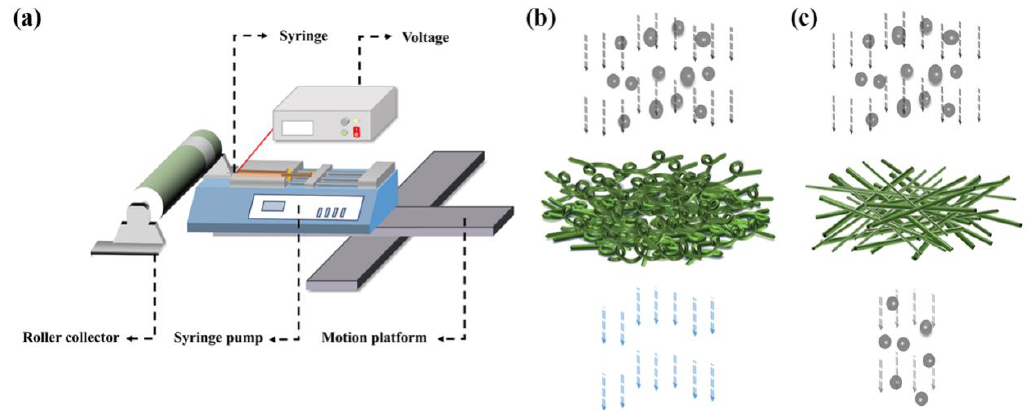
Figure 1. Schematic diagram of electrospinning setup and nanofibrous filtration membrane. ( a ) electrospinning setup; ( b ) air filtration process filtration membrane with curled PVDF nanofiber; ( c ) air filtration process filtration membrane with straight PVDF nanofibrous membrane.